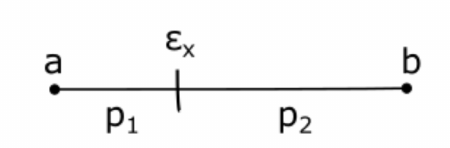
Figure 5. A horizontally-oriented illustration of the interval between any two bounding reference curves and the given ( S , F 1) point between